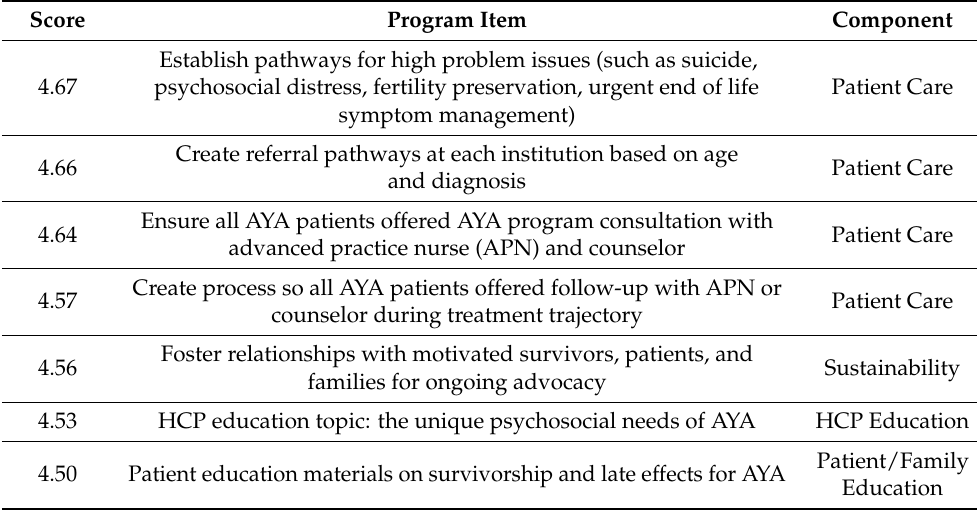
Table 2. Item ratings relating to psychosocial services across all program